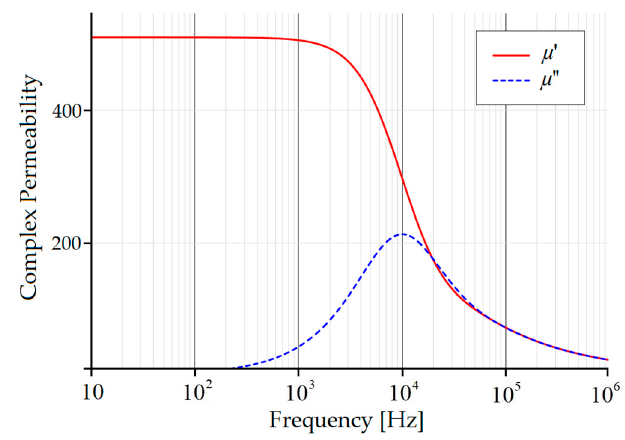
Figure 6. Complex permeability as a function of frequency (2D = 0.23 mm, µ r = 510, γ = 1.2 · 10 6 S / m).